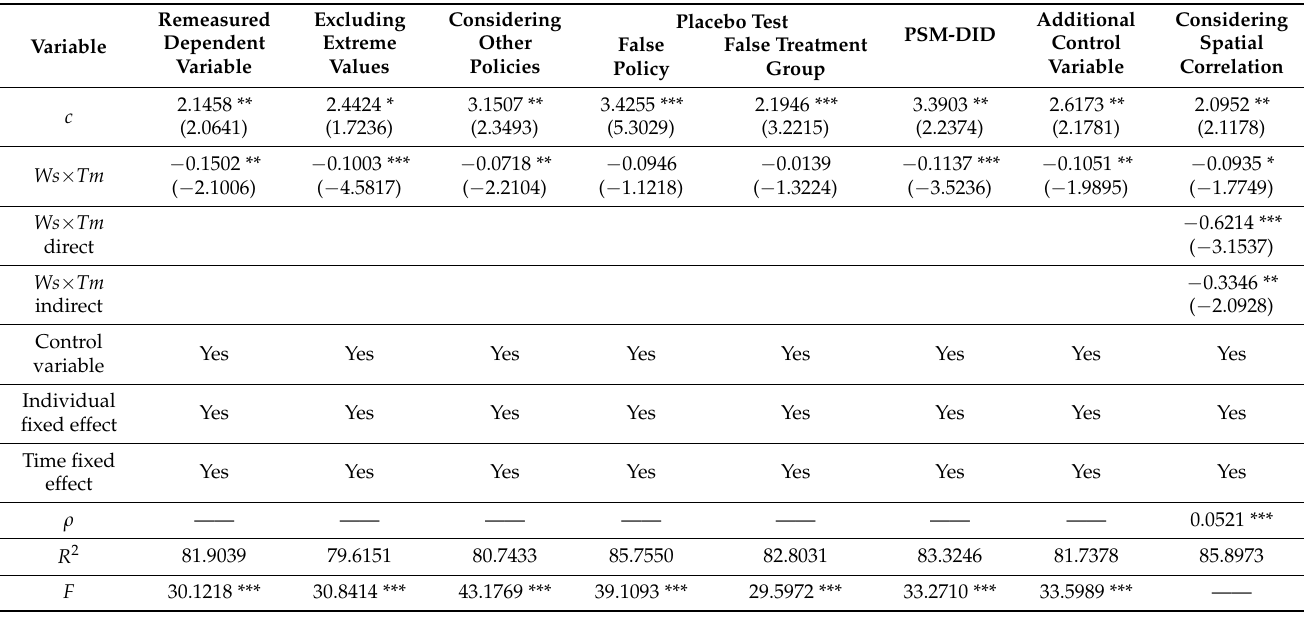
Table 4. Estimation results of robustness